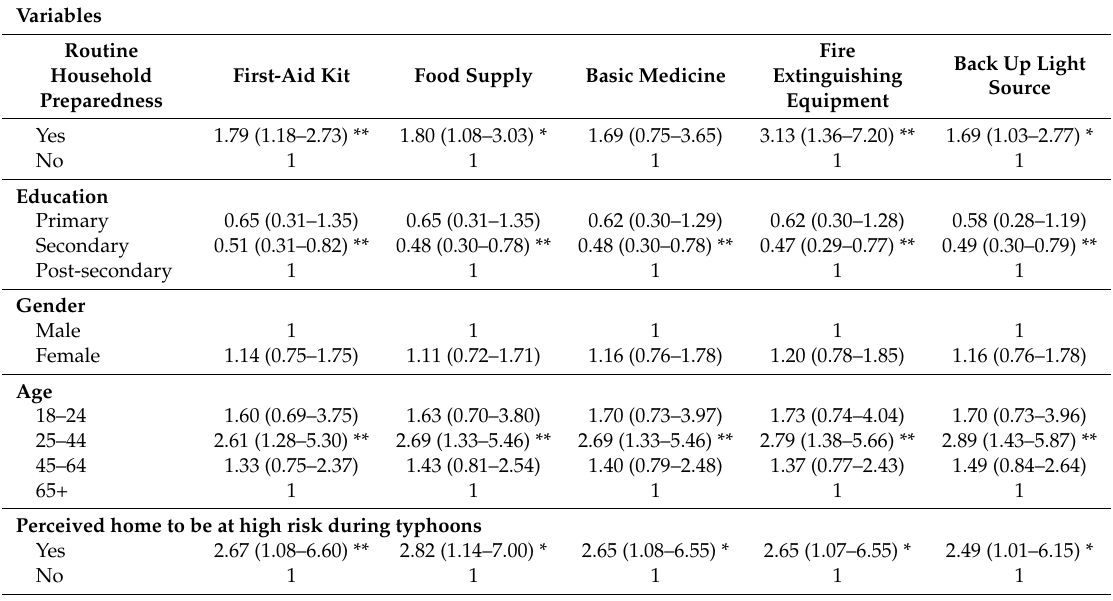
Table A1. Association of practicing at least 1 typhoon-specific preparedness measure (TSPM) and routine household preparedness